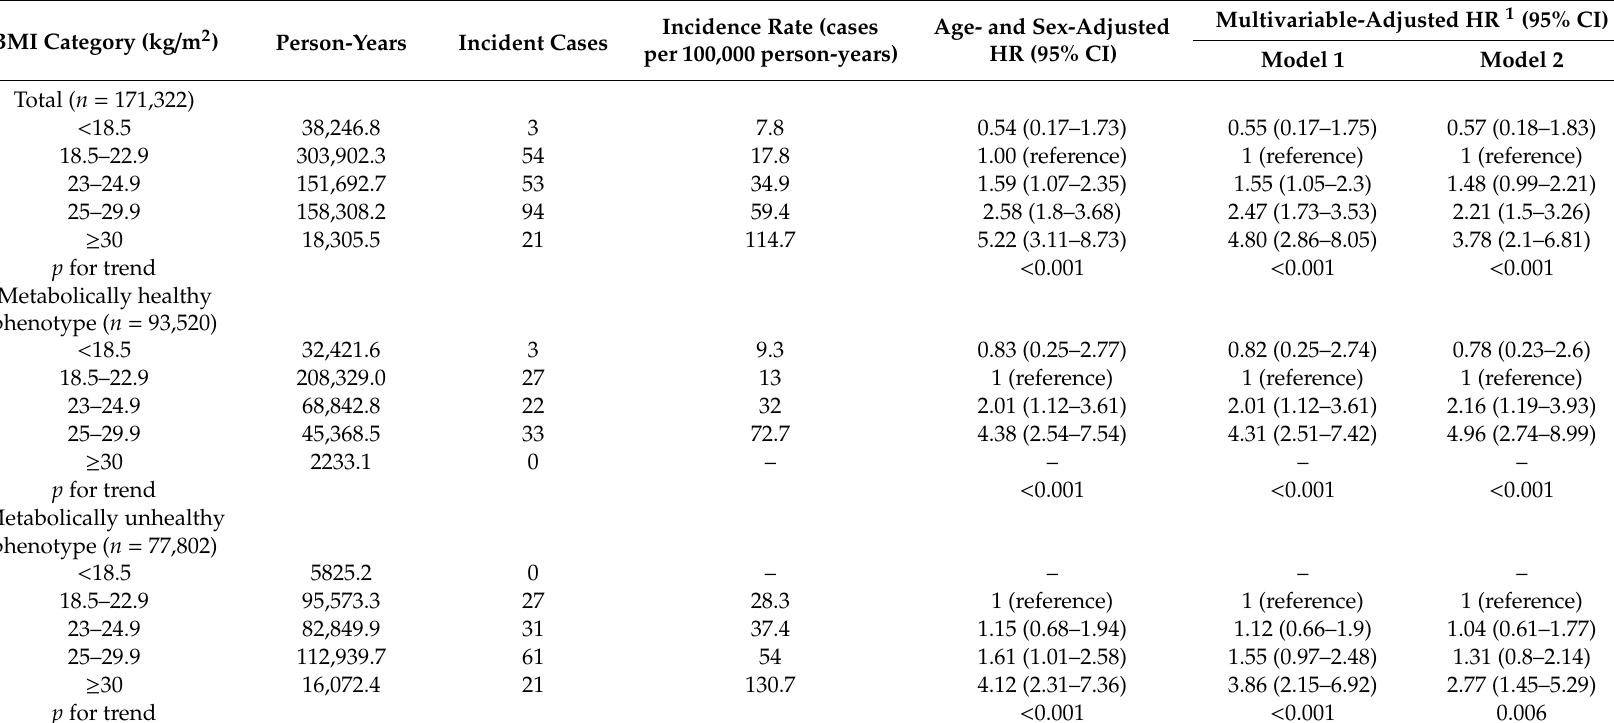
Table 3. Development of cellulitis admission by body mass index category in metabolically healthy and unhealthy phenotypes. BMI Category (kg / m 2